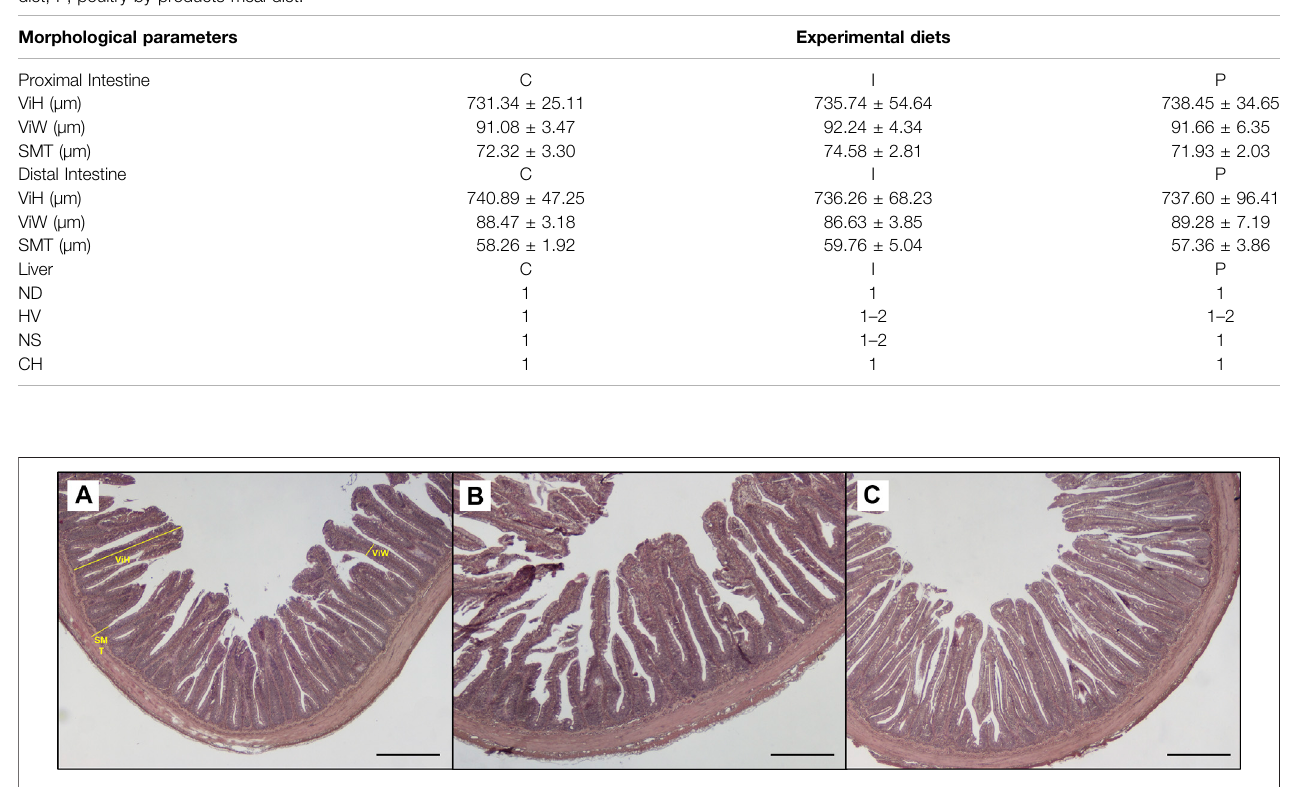
FIGURE5| Lightmicroscopyofproximalintestineportionsoftroutfedcontroldiet (A) ,poultrybyproductsmealdiet (B) andinsectmealdiet (C) .SMT,submucosal layer thickness; ViH, villi height; ViW, villi width. Hematoxylin and eosin, scale bar = 500 μ m.